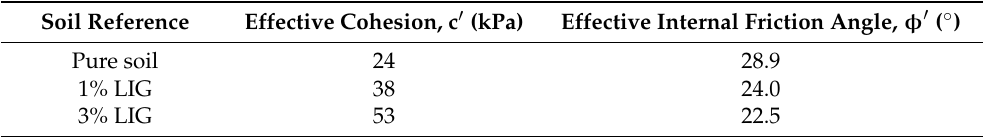
Table 2. Effective friction angle and cohesion of pure soil and LIG-treated soil. Soil